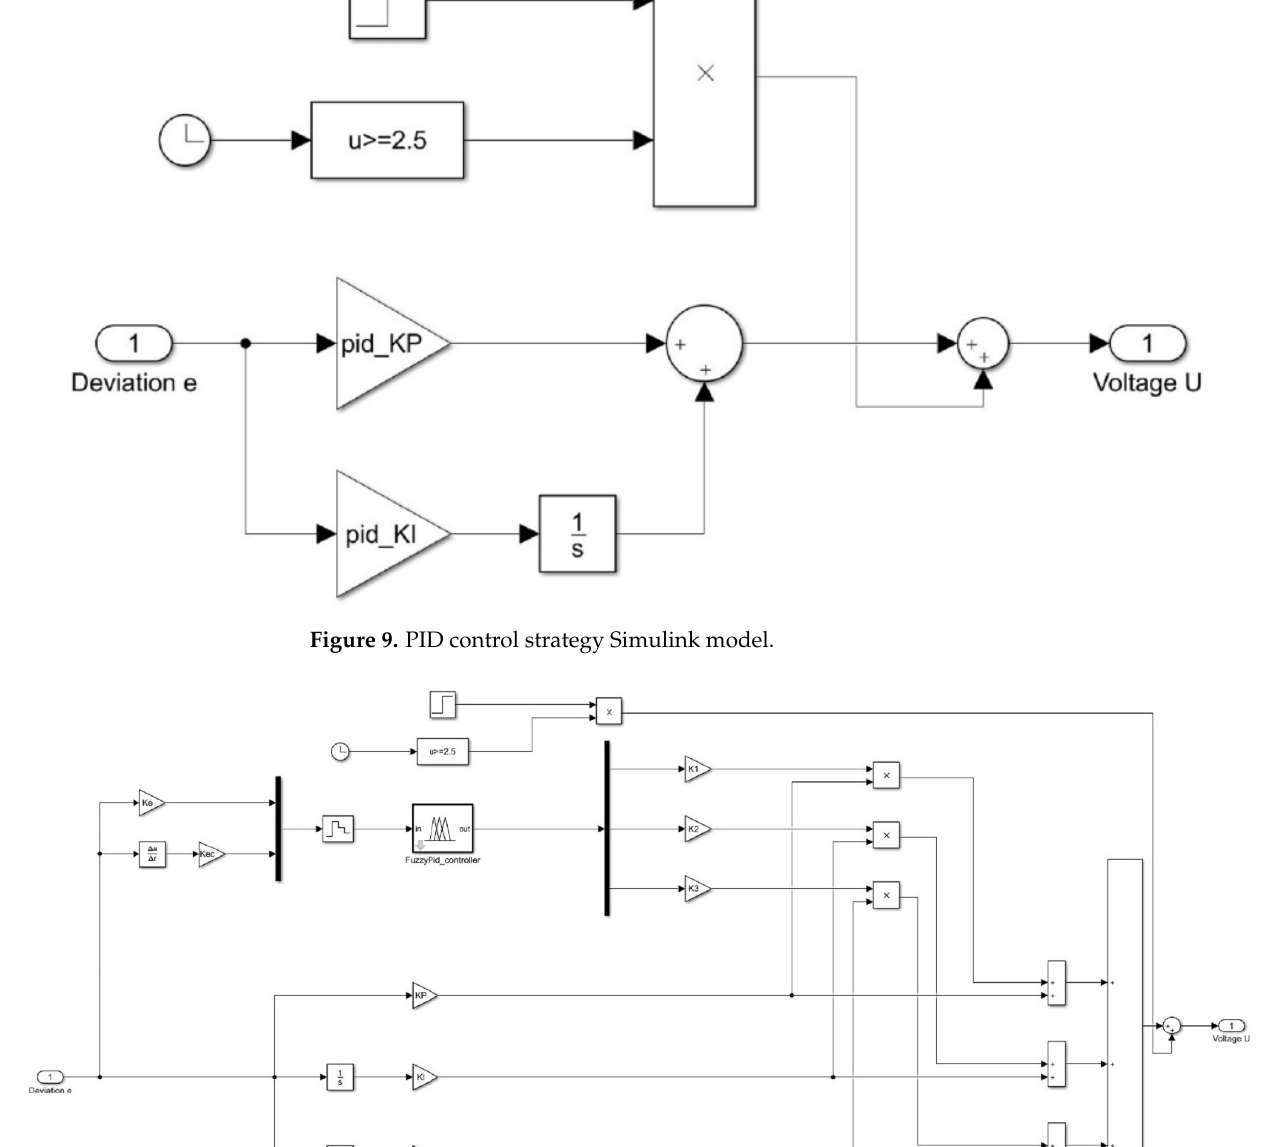
Figure 10. Adaptive fuzzy PID control strategy Simulink model.